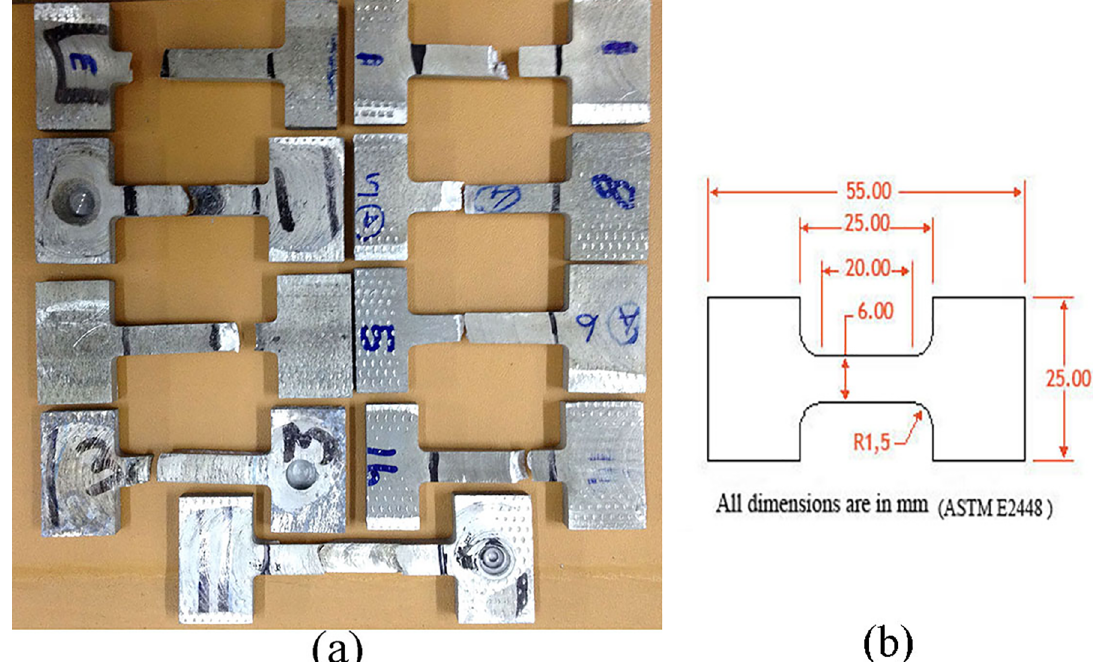
Figure 3. Schematic illustration of (a) Tensile samples (b) Geometry of tensile test